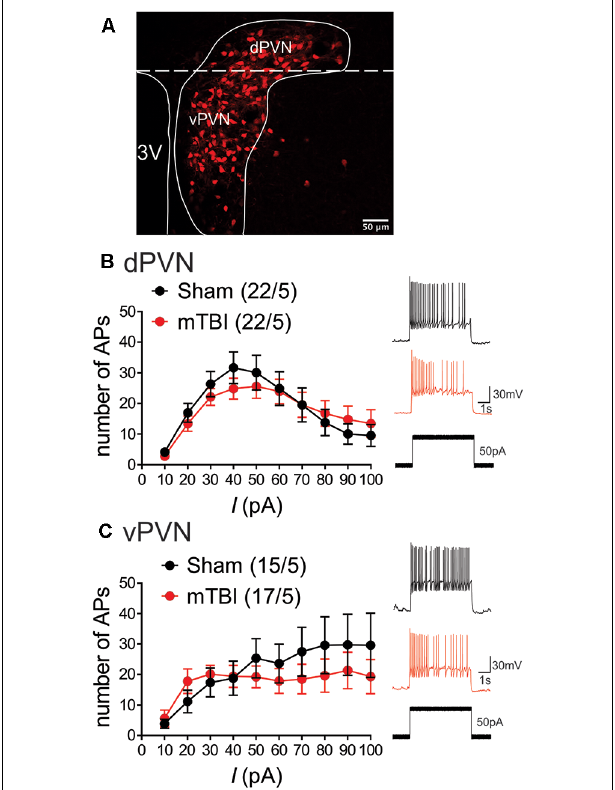
FIGURE 1 | mbTBI does not alter PVN CRF neuronal excitability. (A) Representative image showing the expression of the red fluorescent protein TdTomato in the PVN of the CRF;TdTomato mouse. Overlay is a schematic outline of the PVN labeled as the dorsal (d) PVN and ventral (v) PVN. Average number of action potentials generated across depolarizing current steps in Sham (black) and mTBI (red) mice and representative traces in response to 50 pA stimulation across (B) dPVN and (C) vPVN CRF neurons. Group numbers presented in graph as